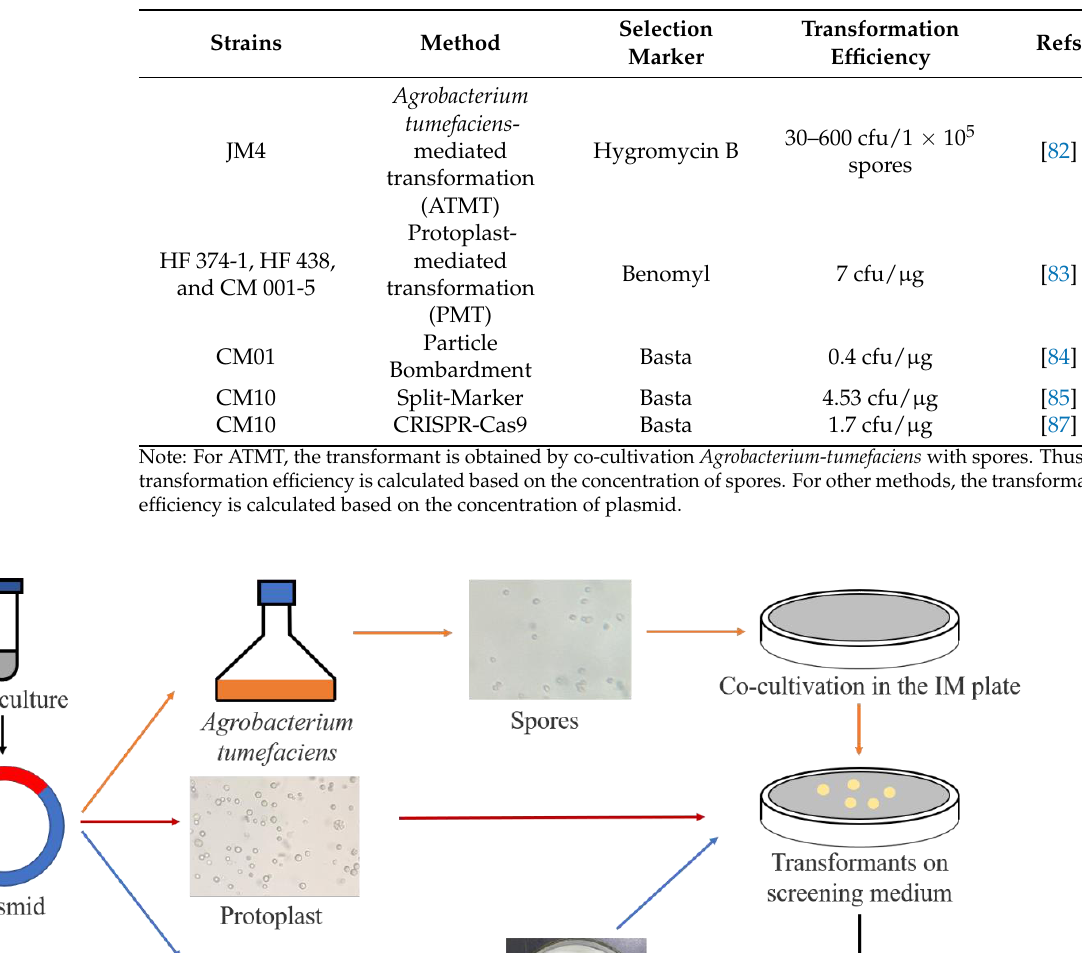
Table 4. Different genetic transformation methods of C. militaris .